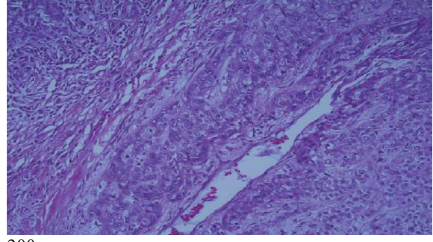
Figure 7: Angioinvasion—SCC has engulfed all muscles layers of a large blood vessel wall. Only the endothelium of the tunica intima remains intact.